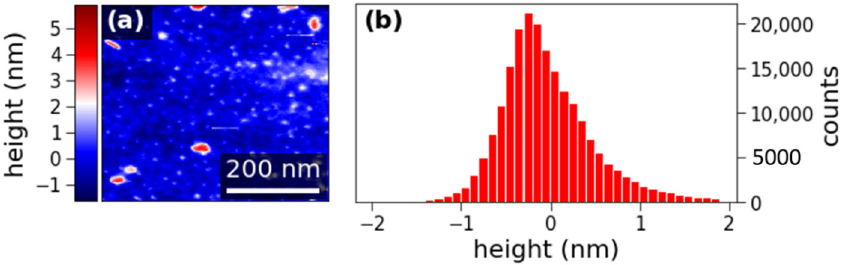
Figure A6. Surface roughness analysis: AFM topography image of the Ti/Pt/Co sample ( a ) and histogram plot of the height distribution ( b ).